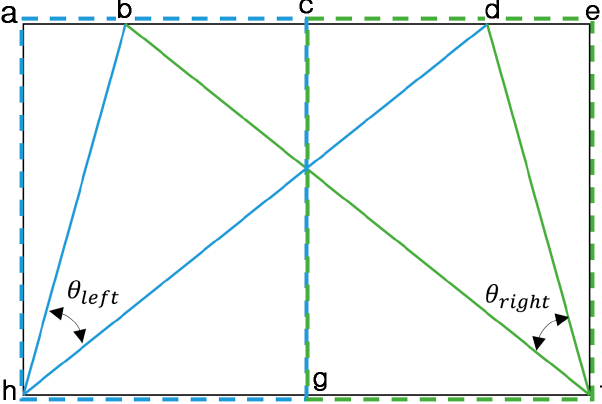
Figure 6. Angle feature used for eliminating incorrect line segments.